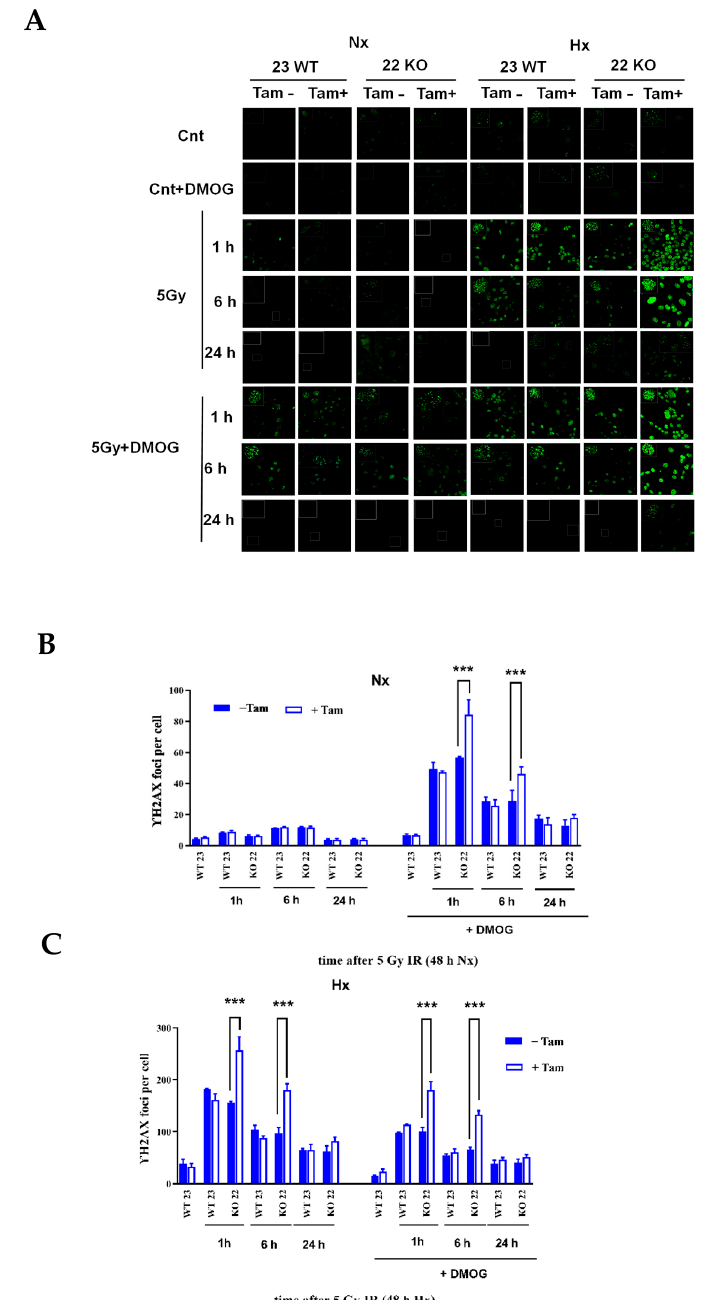
Figure 9. Formation of γ H2AX foci after IR in HIF-1 α knockout mHDC under normoxia or moderate hypoxia, and after treatment with the hydroxylase inhibitor DMOG. The mHDC were incubated in normoxia (NX) or moderate hypoxia (HX), respectively, for 48 h and then irradiated with 5 Gy. The cell cultures were then transferred back to hypoxia or normoxia and stained after the time indicated. Images were taken with a Zeiss LSM510 confocal microscope ( A ). Fields of vision with more than 50 nuclei were evaluated by counting the γ H2AX foci in normoxia ( B ) or hypoxia ( C ). The first pairs of bars designated WT23 represent mHDC which contain HIF-1 α and were not irradiated. Each experiment was performed three times. Graphs show mean ± SD, groups were compared using two-way ANOVA and the Bonferroni post hoc test, *** p < 0.001.